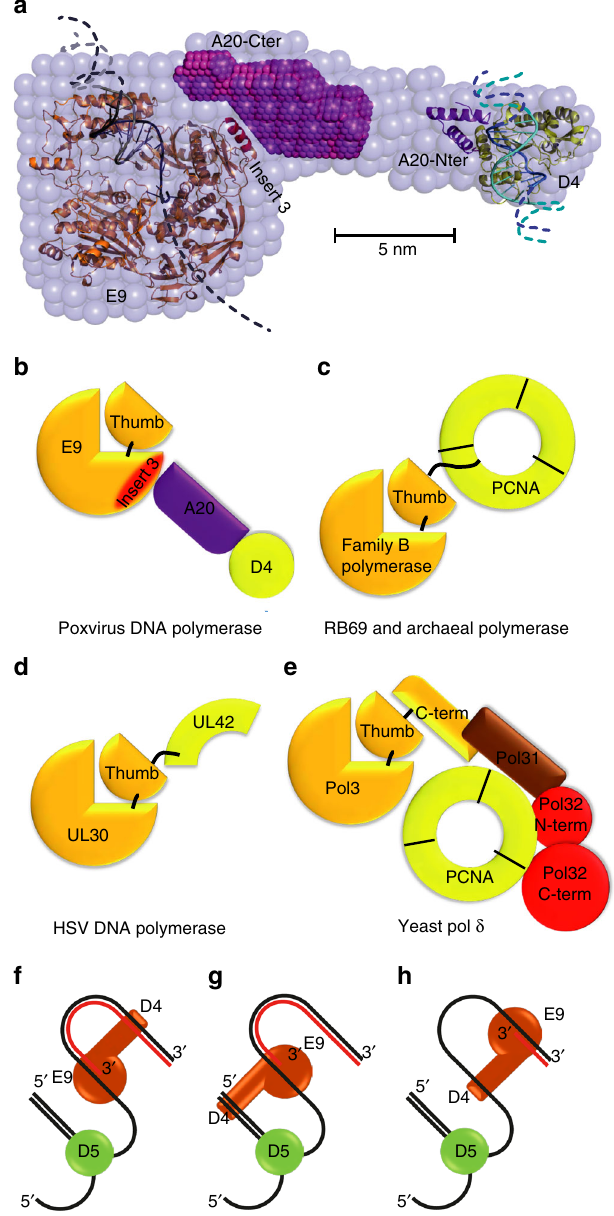
Fig. 5 Models of polymerase holoenzymes. a Model of the VACV holoenzyme. The envelope obtained by SAXS 11 is used to de fi ne the global outline. Components of the polymerase holoenzyme have been placed manually: a model of E9 in complex with DNA in elongation mode, the D4/ A20 1 – 50 complex with bound DNA (A20 1 – 50 , in violet, D4 in yellow, and DNA in blue) 13 , the SAXS ab initio model of the C-terminal fragment of A20 (magenta). Schematic view of the processivity factor binding of b E9, c archaeal and phage DNA polymerases, d HSV DNA polymerase, and e S. cerevisiae polymerase δ . Different orientations of the holoenzyme (brown) at the replication fork, where D4 binds either the newly synthesized dsDNA strand ( f ), or the incoming template strand before ( g ) or after ( h )